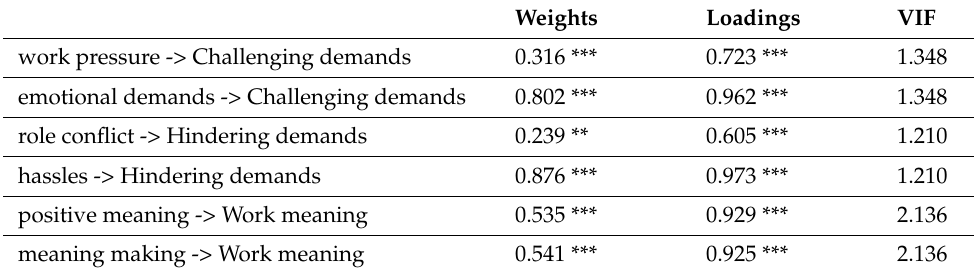
Table 4. Quality assessment for formative